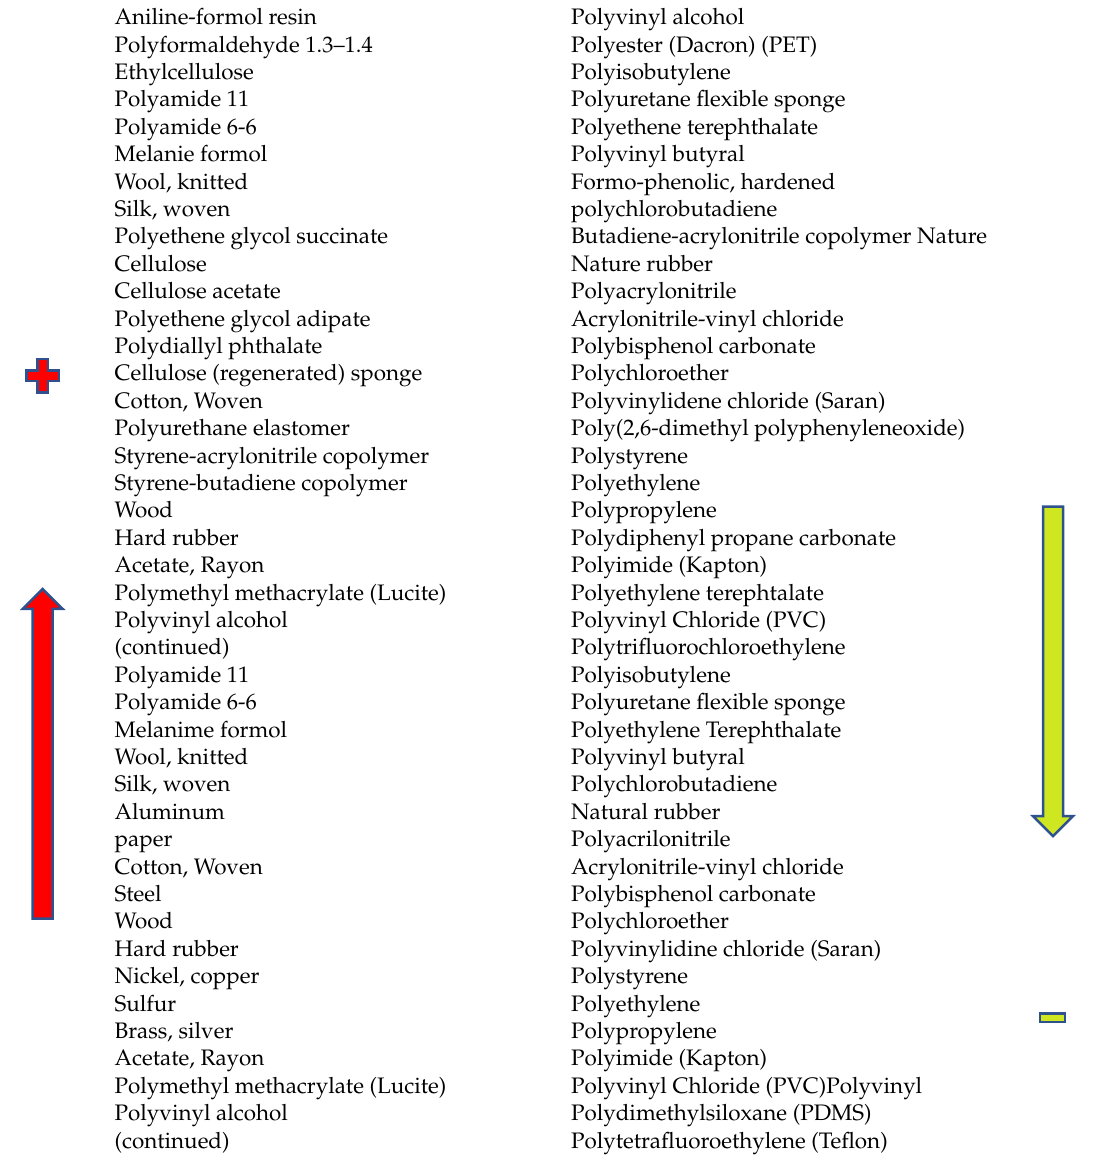
Table 4. Triboelectric series for some commonly available materials